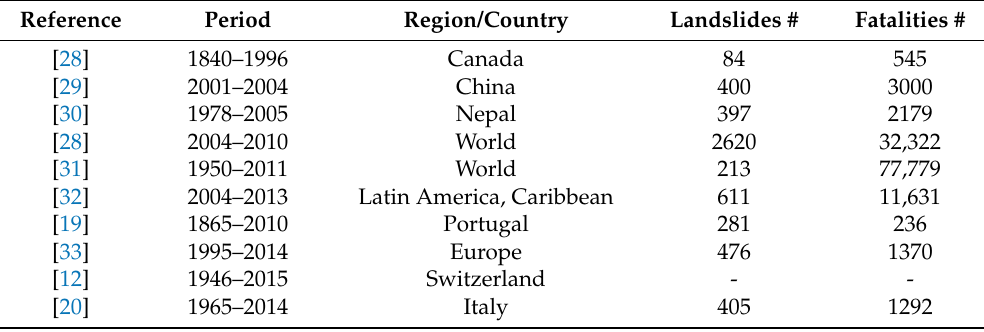
Table 2. Review of papers containing data on landslide